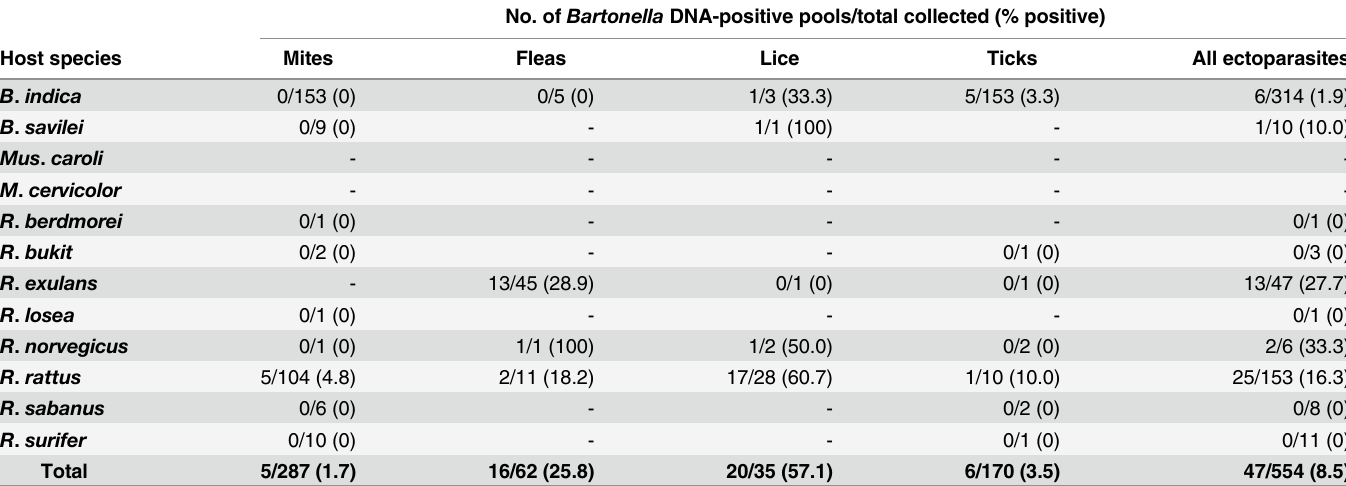
Table 4. Prevalence of Bartonella DNA-positive ectoparasites by rodent species based on detection of the ssr A gene fragment.